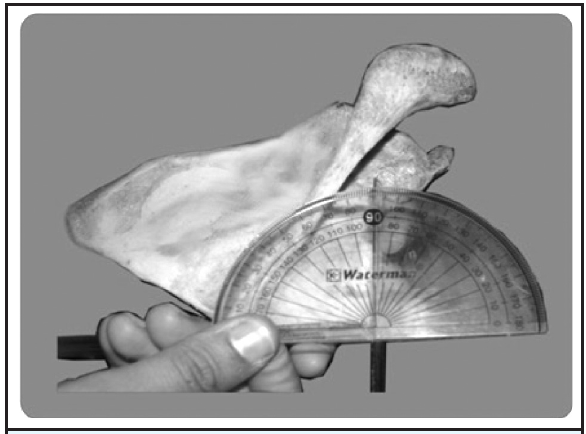
1. Superomedial/Superior angle: It was measured as the angle where the superior border meets the medial or the vertebral border of the scapula. 2 For measuring this angle, one scale was placed along the superior border of the scapula and another scale was placed along the medial border on the supraspinous line and angle between both was measured with the help of protractor (Figure1 and 2).